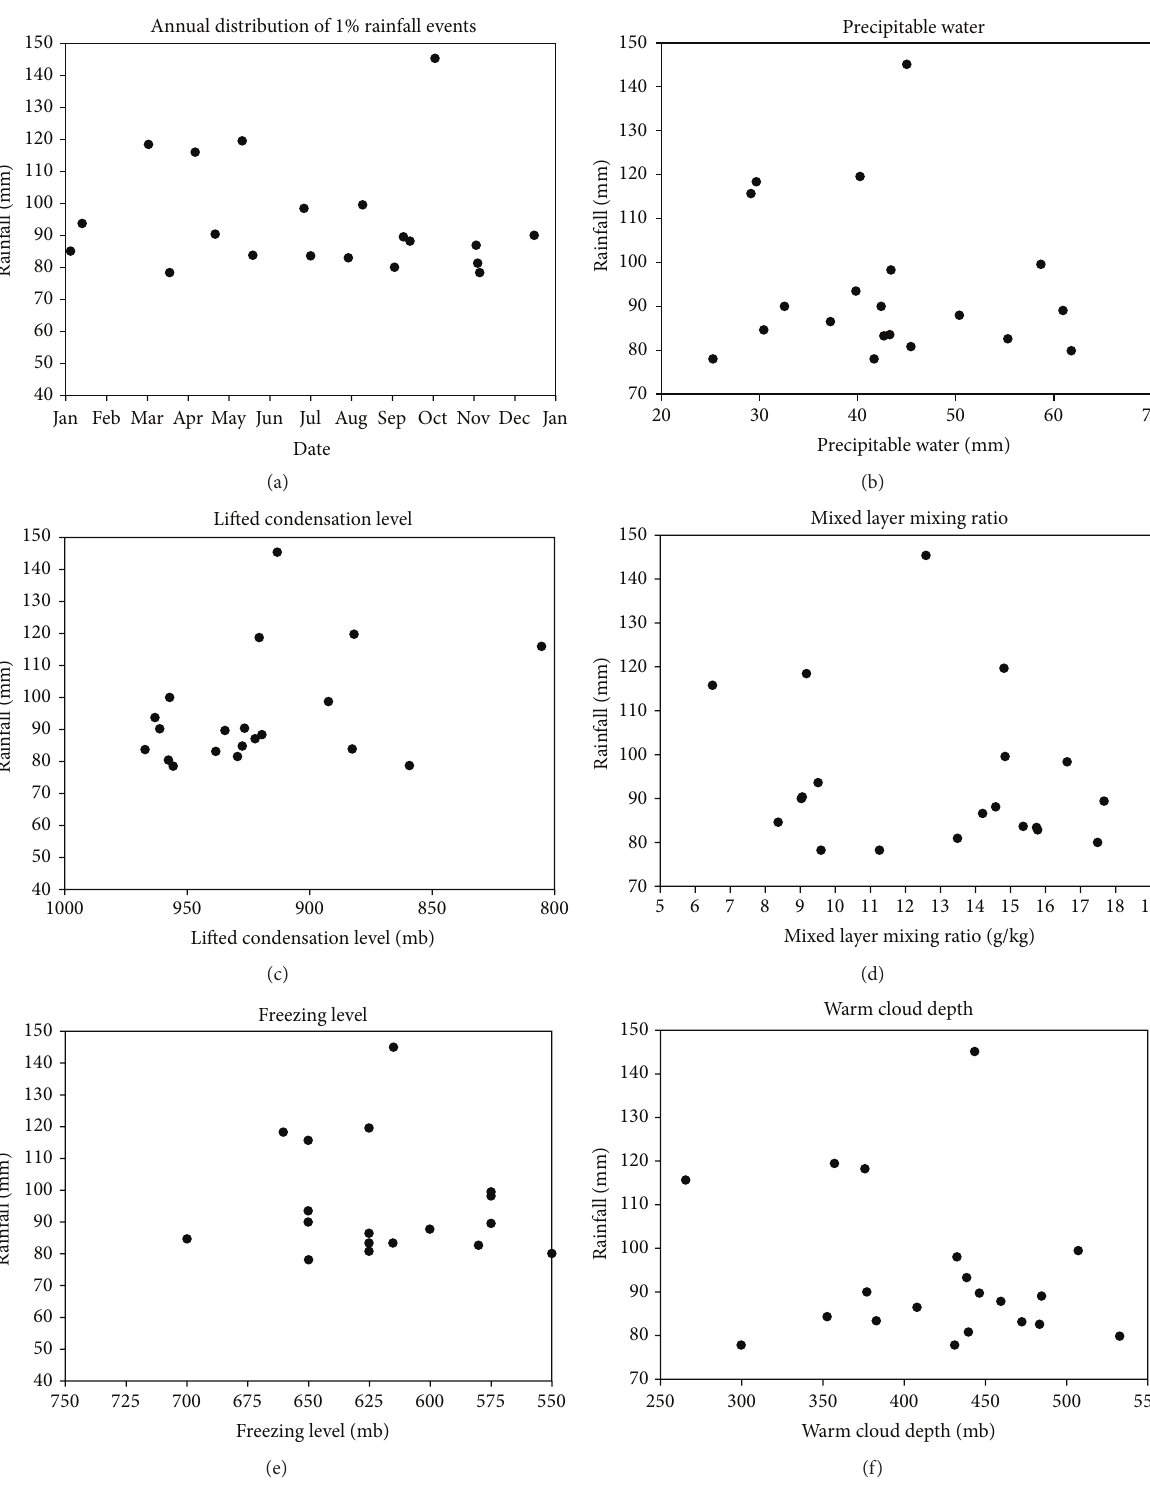
Figure 7: Ft. Smith graphs. (a) Annual distribution of 1% cases. (b) Magnitude of rainfall versus PWater. (c) Magnitude of rainfall versus LCL height. (d) Magnitude of rainfall versus MLMR. (e) Magnitude of rainfall versus freezing level. (f) Magnitude of rainfall versus